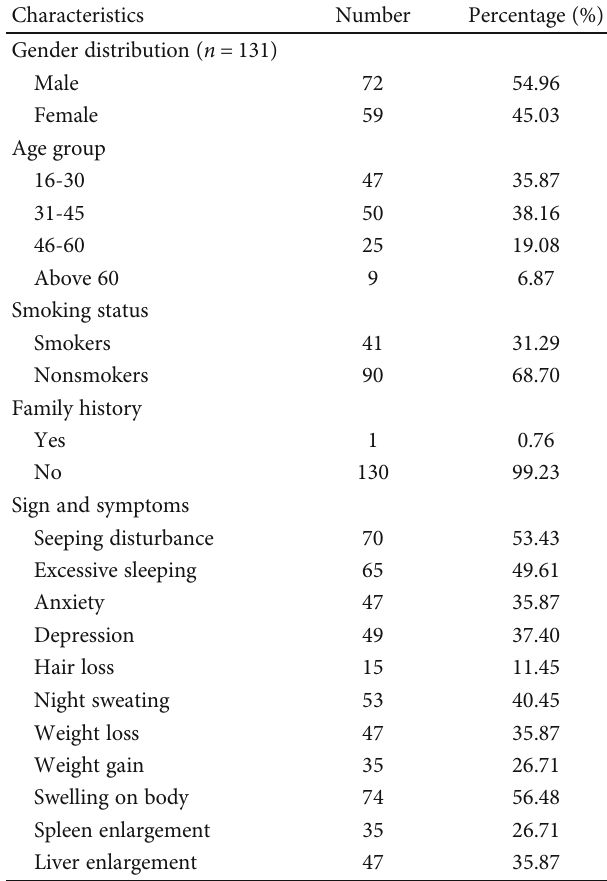
Table 1: General characteristics of CML patients ( n = 131